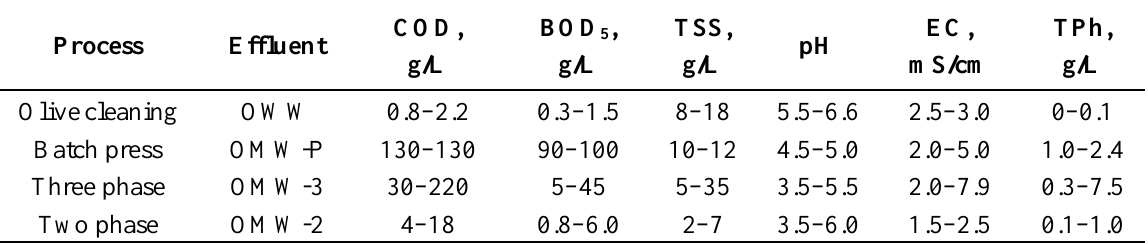
Table 1. Characteristics of the effluents of batch and continuous olive oil extraction processes [3].